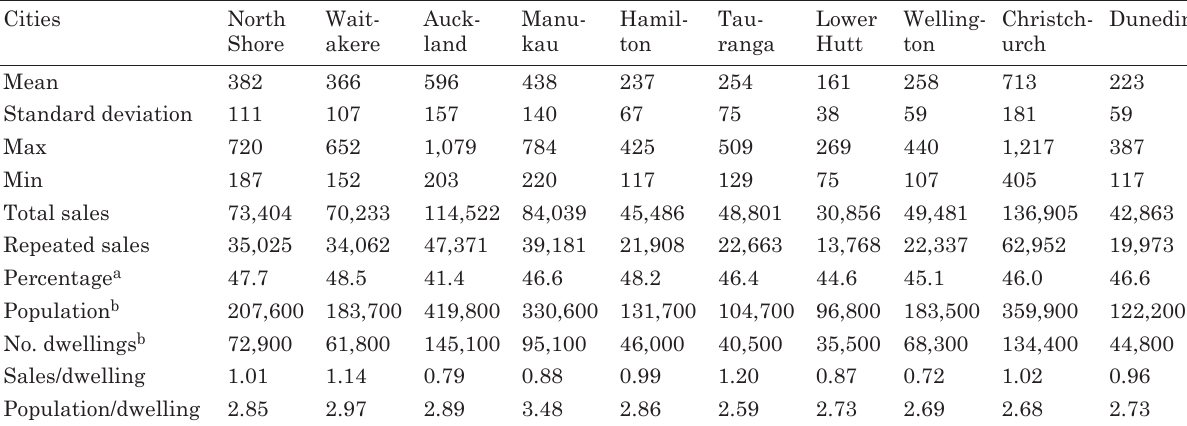
Table 2. Summarised monthly house sales statistics for the top 10 cities in New Zealand, Jan 1994–Dec